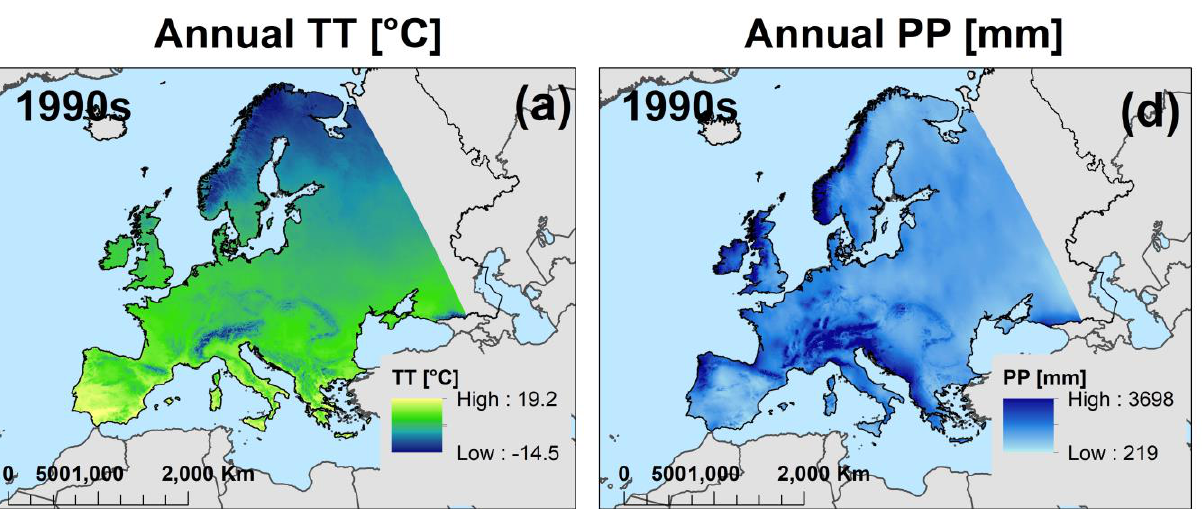
Figure 1. Climate variables as input data in Europe and output results list. ( a ) Mean annual air temperature (TT) in 1990s. ( b ) Mean annual air temperature (TT) in 2020s. ( c ) Mean annual air temperature (TT) in 2050s. ( d ) Mean annual precipitation (PP) in 1990s. ( e ) Mean annual precipita- tion (PP) in 2020s. ( f ) Mean annual precipitation (PP) in 2050s. 3.2. Geological Data and Aquifers The International Hydrogeological Map of Europe, from 2013, at a 1:1,500,000 scale [29,30], was used in this study to differentiate the main geological formations and to